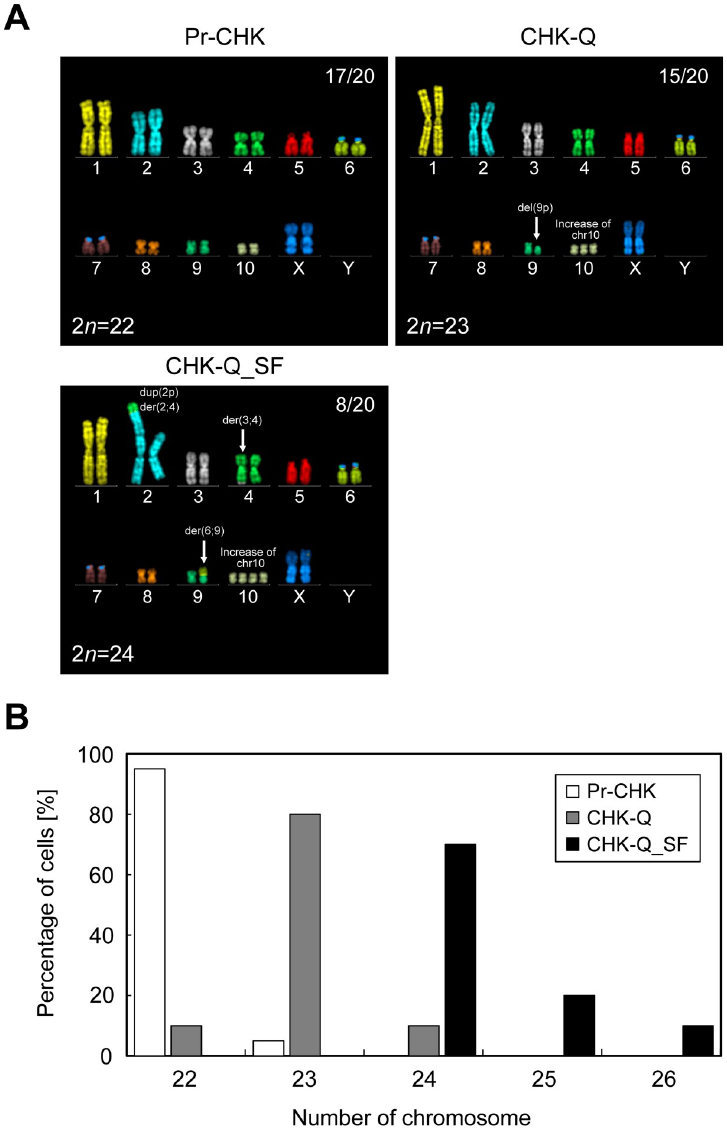
Fig 2. Karyotype analysis and chromosome distribution. (A) Chromosomal structure of Chinese hamster kidney- derived primary cells, Pr-CHK, immortalized CHK-Q, and serum-free-adapted CHK-Q_SF cells. Cells were subjected to multicolor FISH/FISH analysis to evaluate the karyotype. All results of the karyotype analysis are summarized in S2– S4 Tables. del(9p), deletion of the short arm of chromosome 9; der(2;4), derivative chromosome